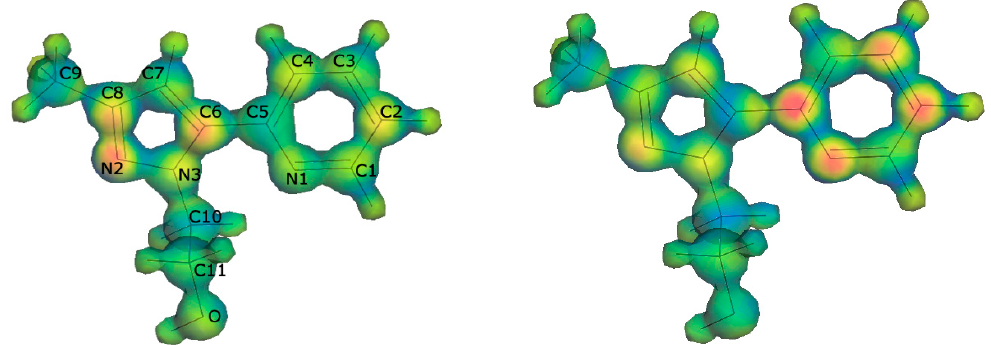
Figure 7. Representation of the Fukui functions projected onto the electrostatic potential (Higher values correspond to red zones). Left: electrophilic f( − ) and right: nucleophilic f(+). Lower values correspond to blue zones, whereas the green/yellow represents a potential halfway between the two extremes